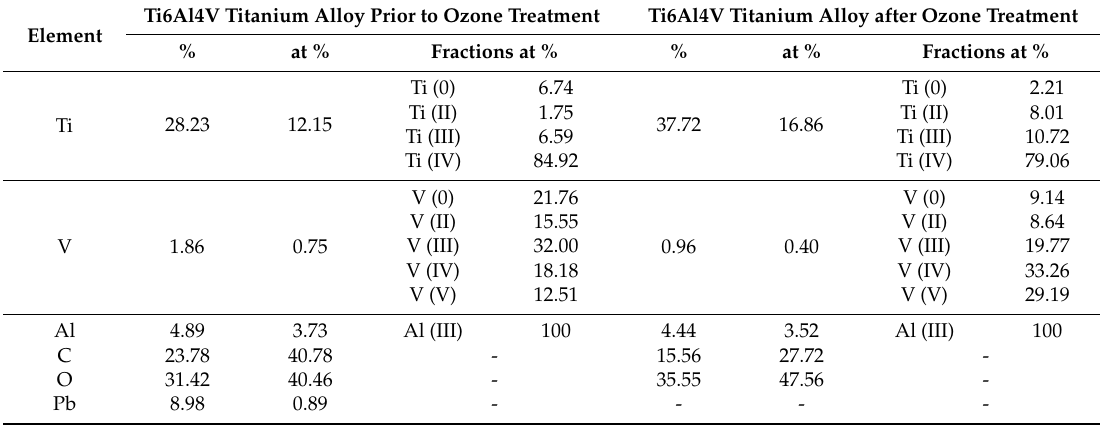
Table 2. The chemical composition of Ti6Al4V titanium alloy prior to and after ozone treatment. Ti6Al4V Titanium Alloy Prior to Ozone Treatment Ti6Al4V Titanium Alloy after Ozone Element